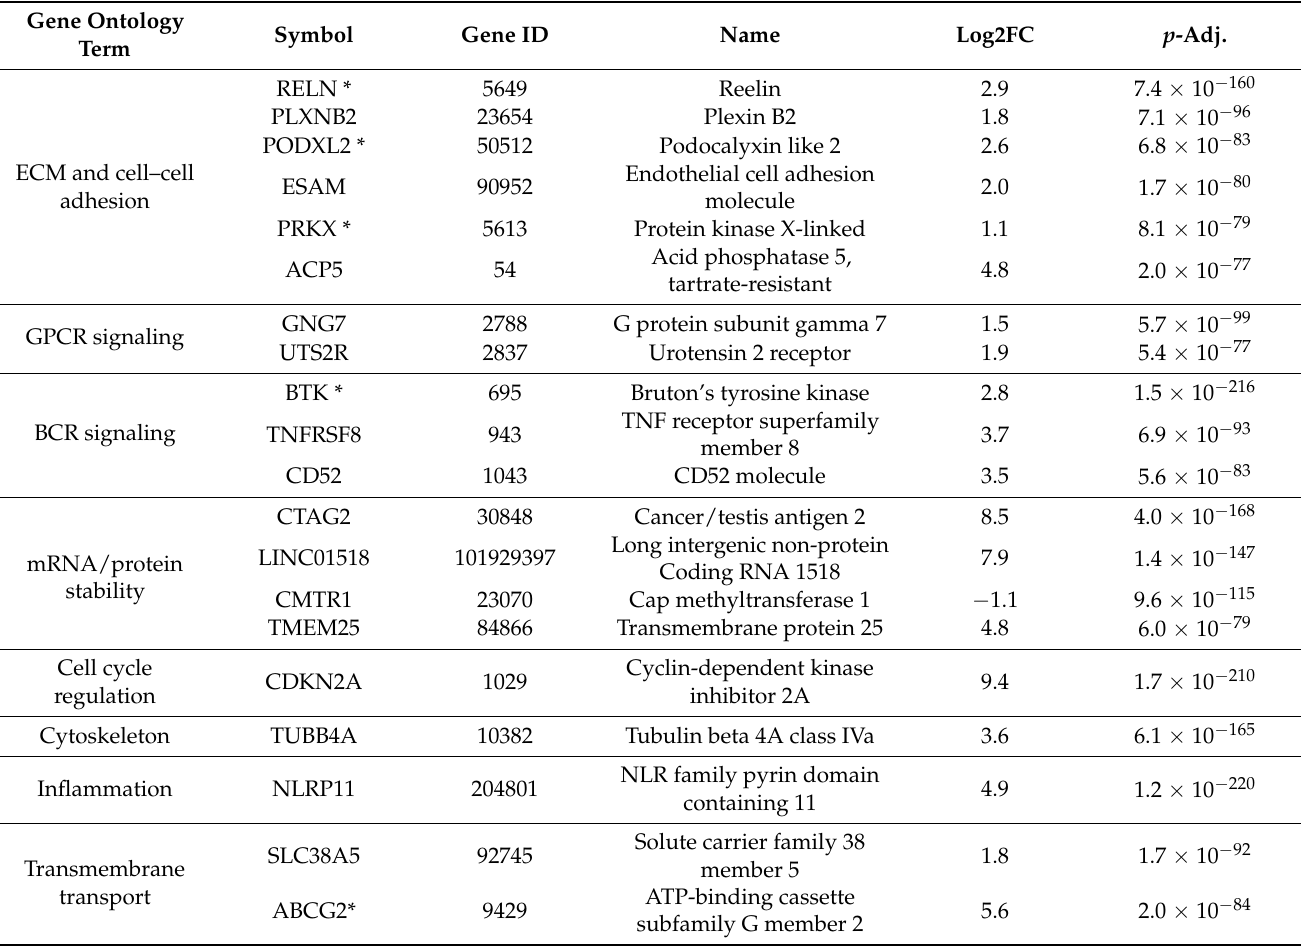
Table 1. Overview of top 20 most significantly differentially expressed genes (logFC > 1 or logFC < − 1) between glucocorti- coid (GC)-resistant MM1R and GC-sensitive MM1S